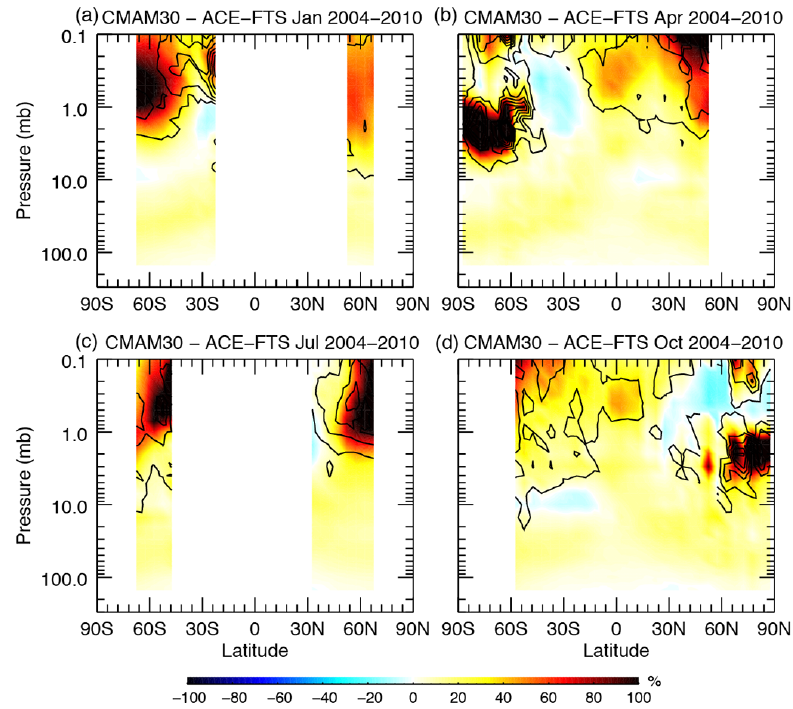
Figure 6. Same as for Fig. 2 but for CMAM30 vs. ACE-FTS relative differences for methane profiles for 2004 to